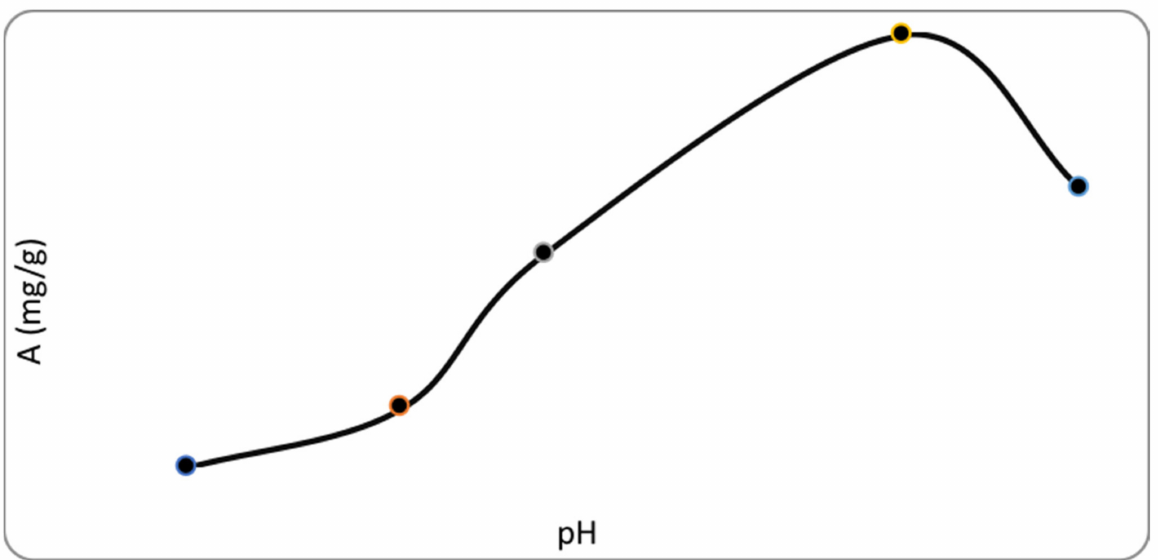
Figure 9. Dependence of adsorption capacity on